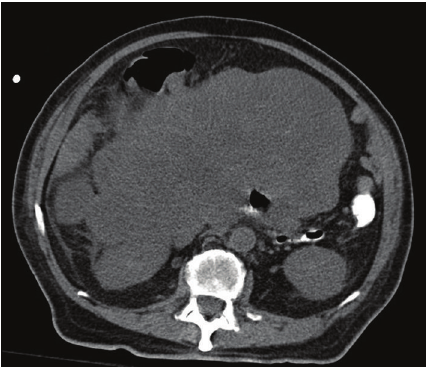
Figure 2: Large retroperitoneal mass near right colon and